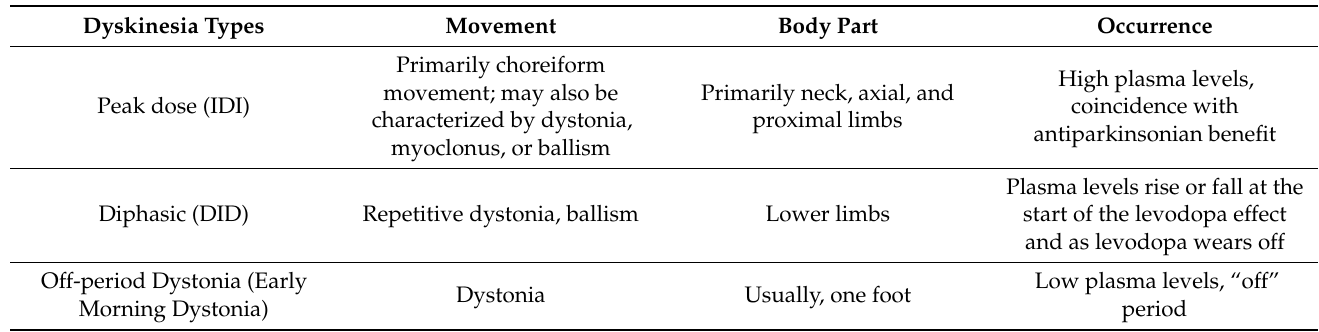
Table 1. Different types of